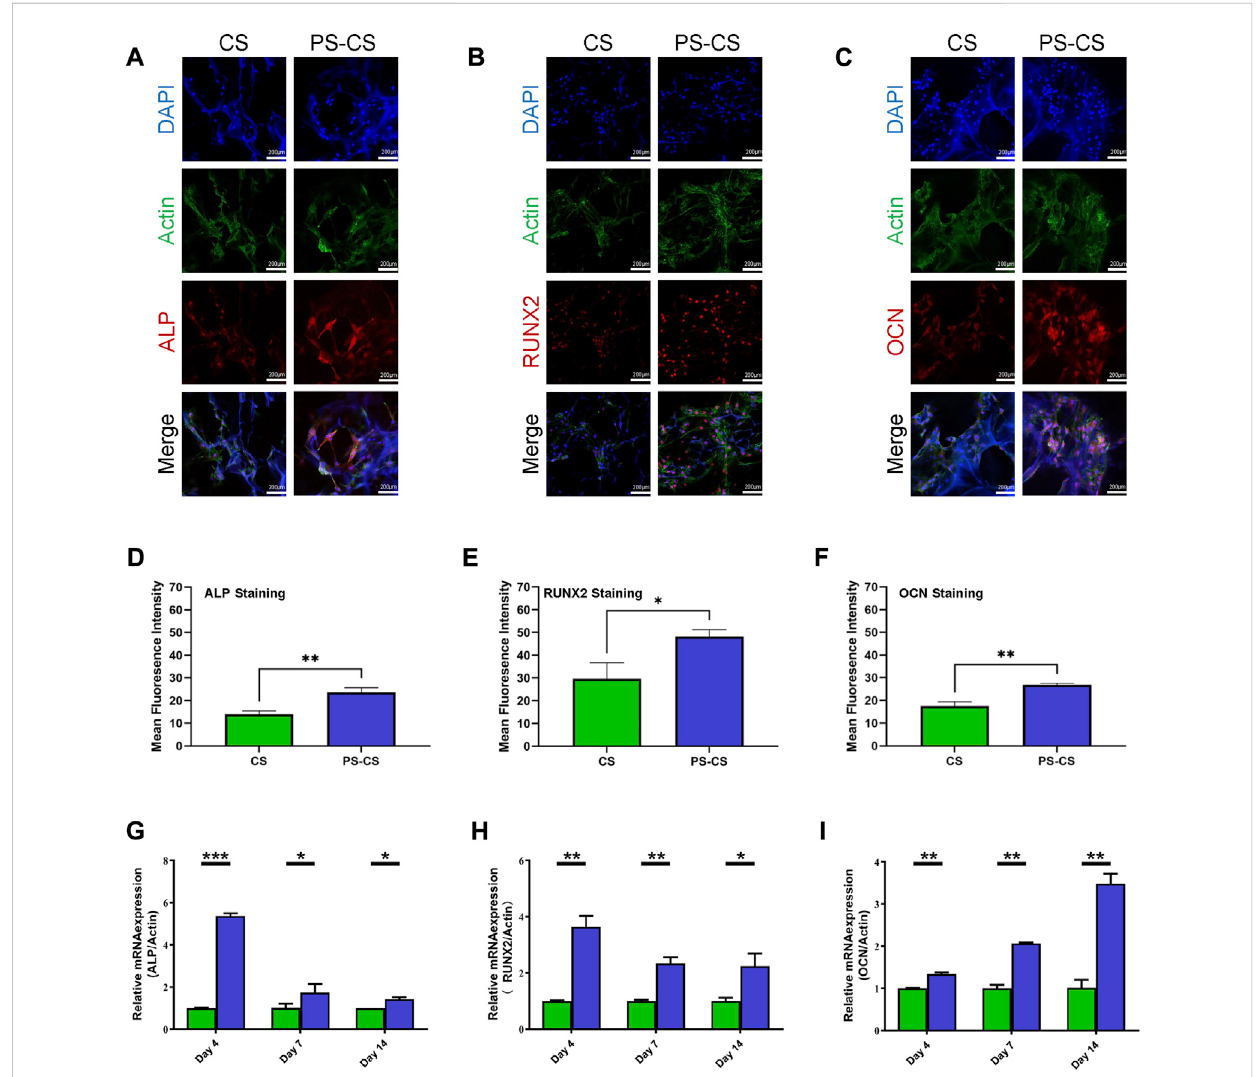
FIGURE 5 Immuno fl uorescentstainingofosteogenic-relatedmarkers. (A) :ALPstainingofBMSCsculturedonthemembranesfor5 days. (B) :RUNX2stainingofBMSCs cultured on the membranes for 9 days. (C) : OCN staining of BMSCs cultured on the membranes for 14 days. (D – F) : Quantitative analysis of the fl uorescent intensity of the ALP (D) , RUNX2 (E) , and OCN (F) . Expression of osteogenic-related genes in BMSCs. (G – I) qRT-PCR evaluation of osteogenic gene ALP (G) , RUNX2 (H) , OCN (I) . The data were analyzed statistically using analysis of variance (ANOVA). * p < 0.05; ** p < 0.01; and *** p < 0.001, **** p <